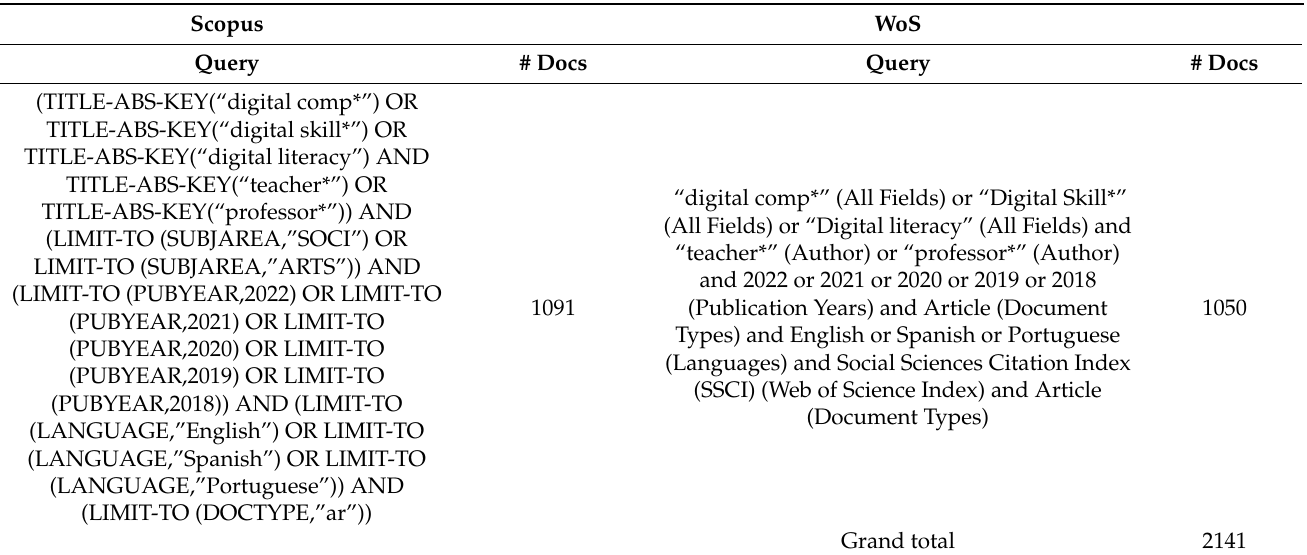
Table 1. Scopus and WoS search